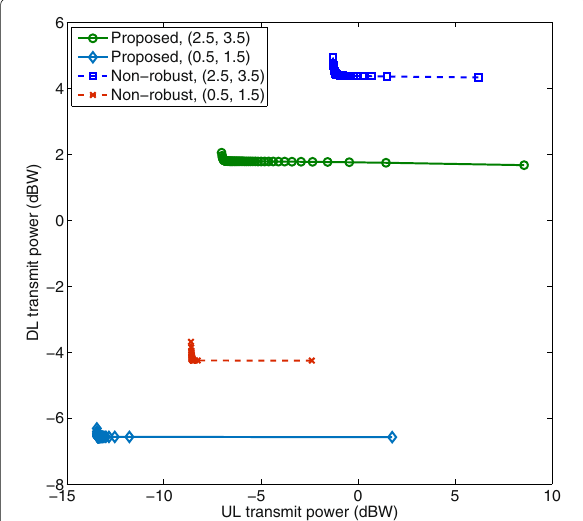
Fig. 3 Average power consumption versus the channel estimate error ratios